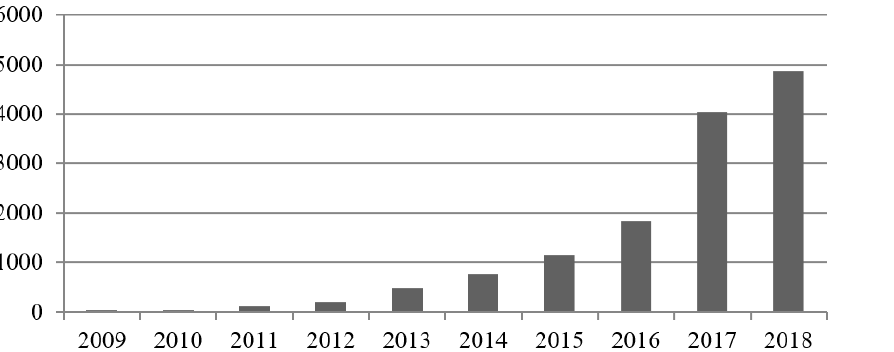
Figure 1. Evolution of the number of research documents published between 2009 and 2018 having the expressions ‘smart city’ or ‘smart cities’ in their title, abstract or keywords, while not having the expression ‘e- government’ in the same fields, as retrieved from the Scopus